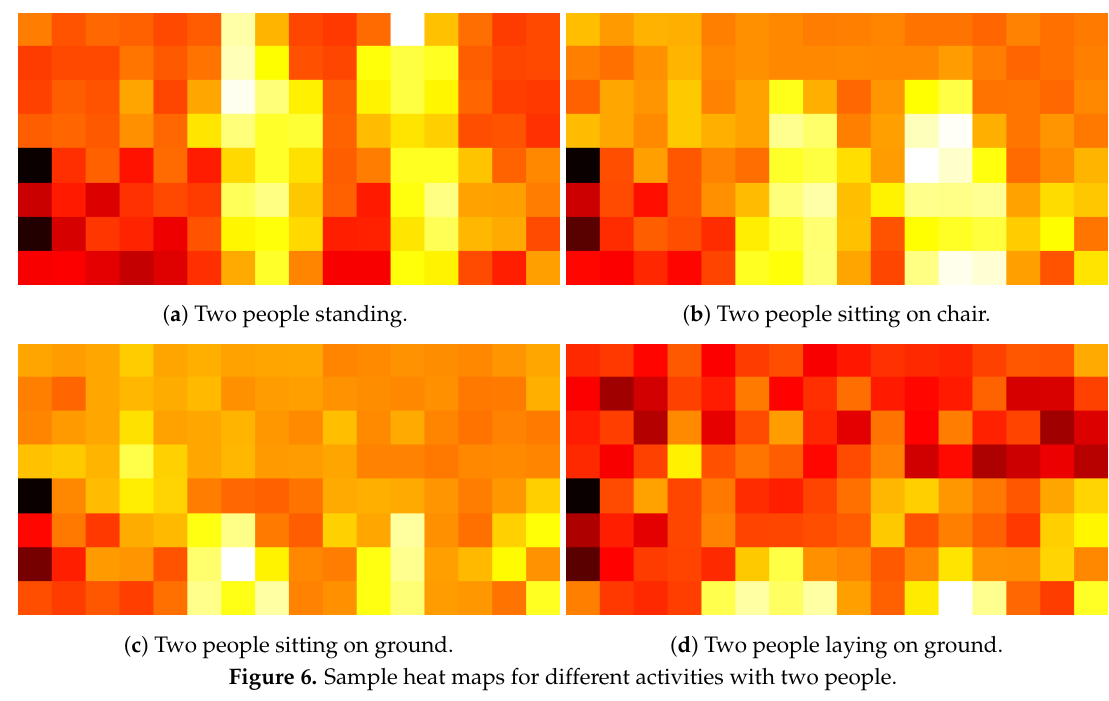
Figure 6. Sample heat maps for different activities with two people.